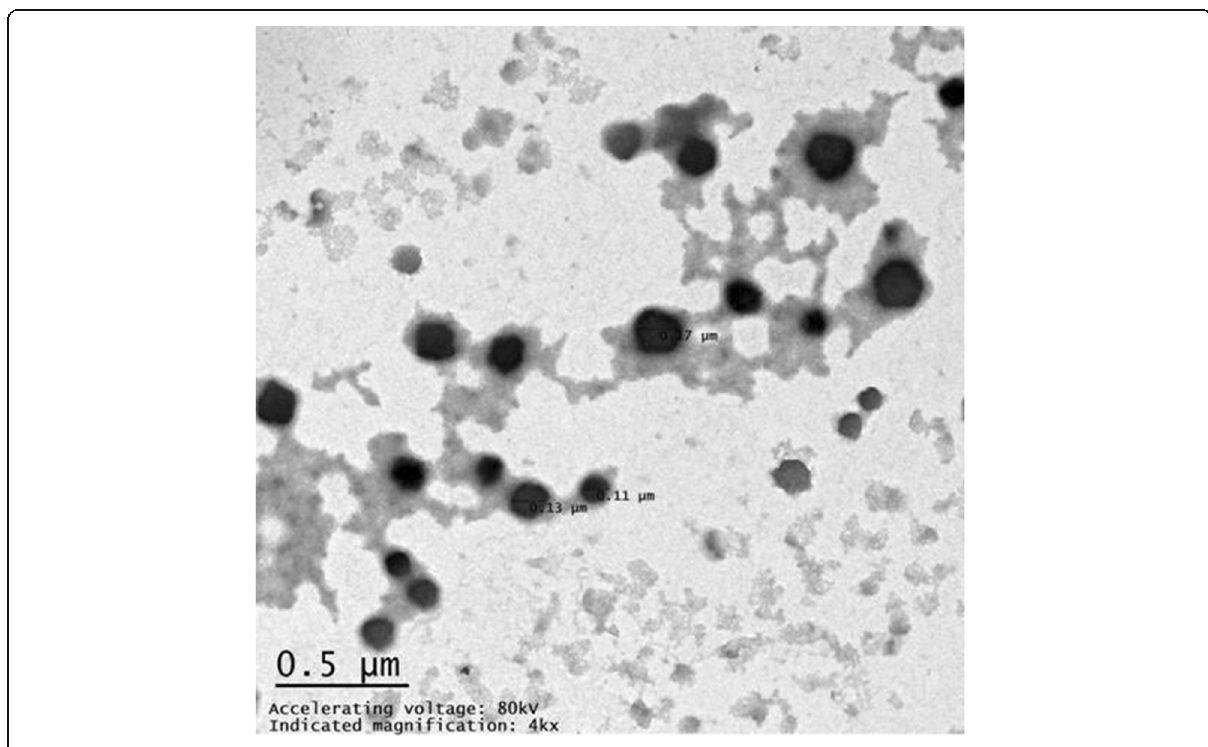
Fig. 5 TEM image of optimized formulation